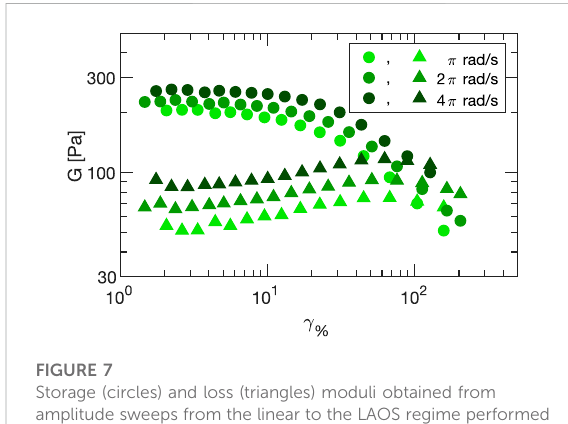
FIGURE 7 Storage (circles) and loss (triangles) moduli obtained from amplitude sweeps from the linear to the LAOS regime performed on Carbopol 5%. Different colors correspond to different angular frequencies ω equal to π rad/s (light green), 2 π rad/s (green) and 4 π rad/s (dark green). Error bars are smaller than the data points. All data are corrected for inertia and sliding friction as described in the main text.